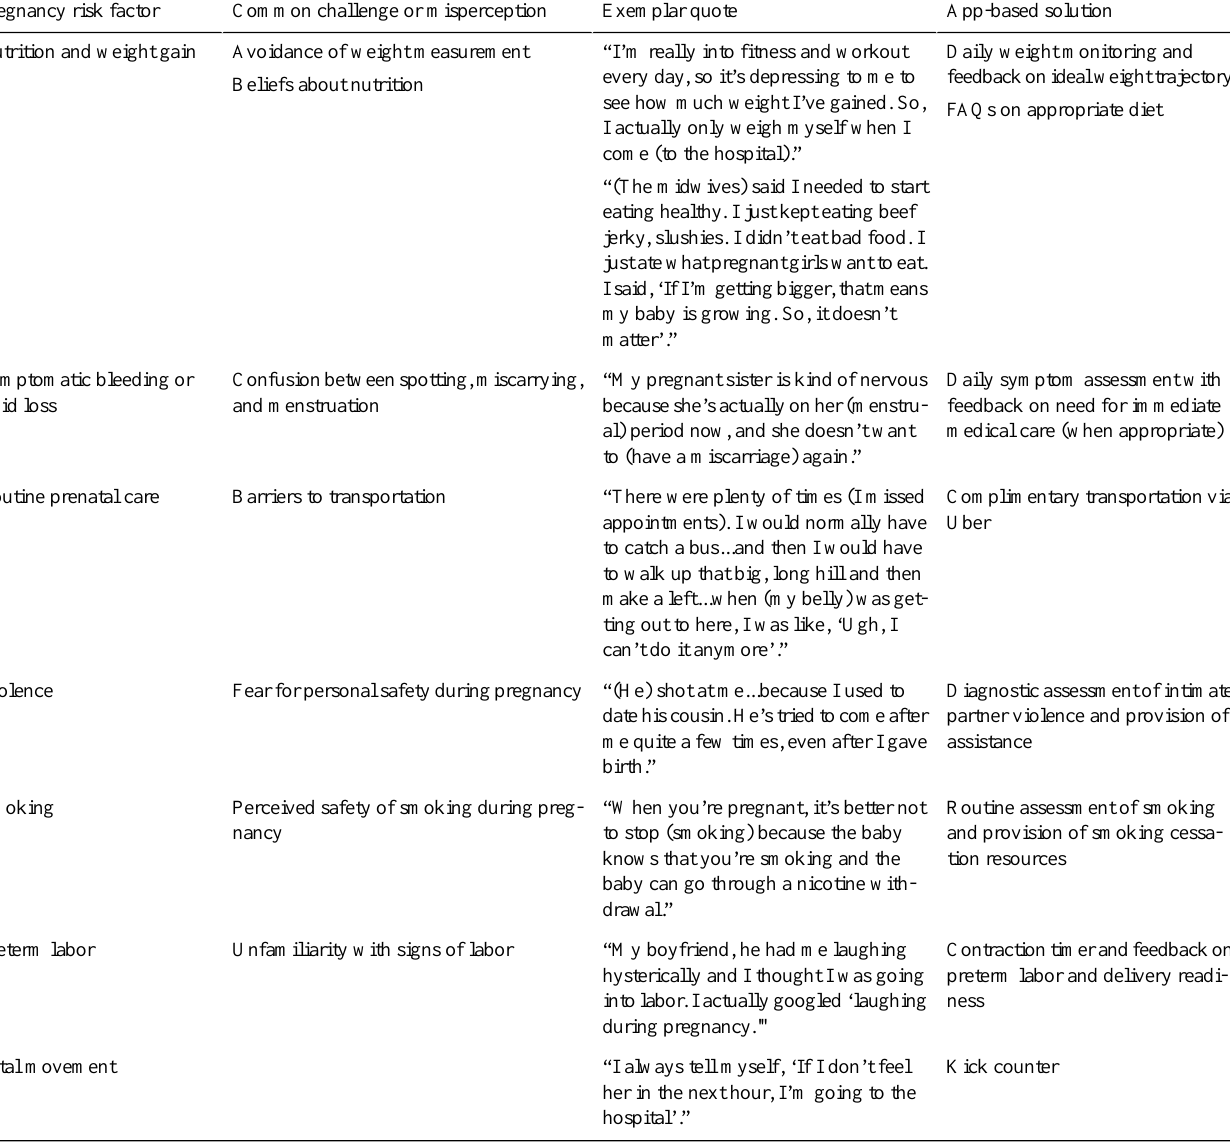
Table 1. Behavioral risk factors identified in normative and descriptive research and addressed in the MyHealthyPregnancy app.